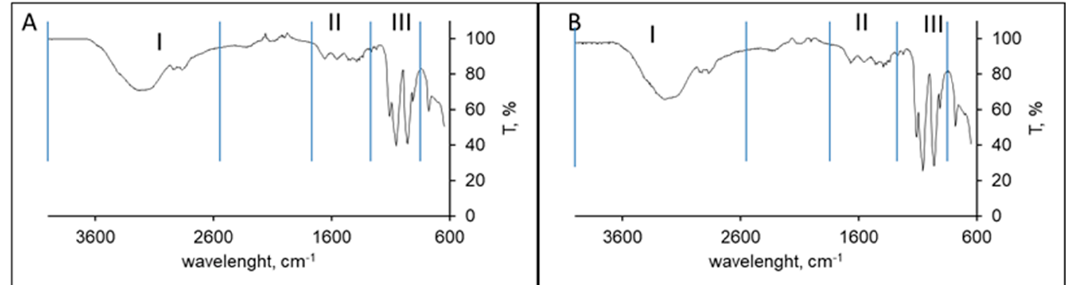
Figure 3. FTIR--ATR spectra of cuttlebone chitosan ( A ) and squid pen chitosan ( B ). Regions I, II and III are indicated in the figure.